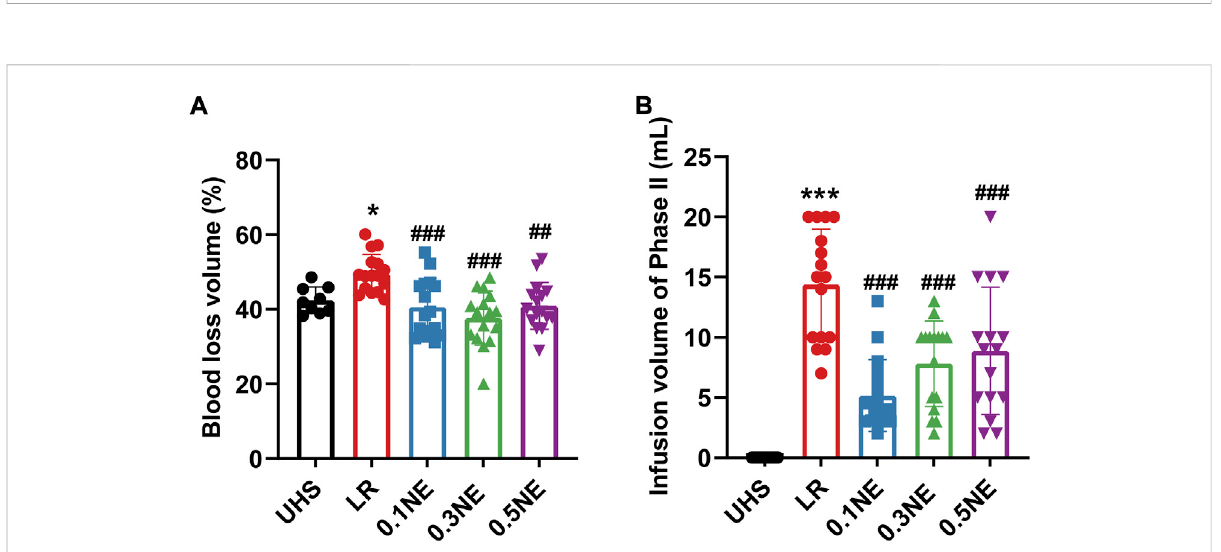
FIGURE 5 The effect of NE on blood loss and infusion volume following 1 h of hypotensive resuscitation. (A,B) Blood loss and infusion volume in the permissive hypotensive maintenance period (Phase II). * p ＜ 0.05, *** p ＜ 0.001 as compared with the UHS group; ## p ＜ 0.01, ### p ＜ 0.001 as compared with the LR